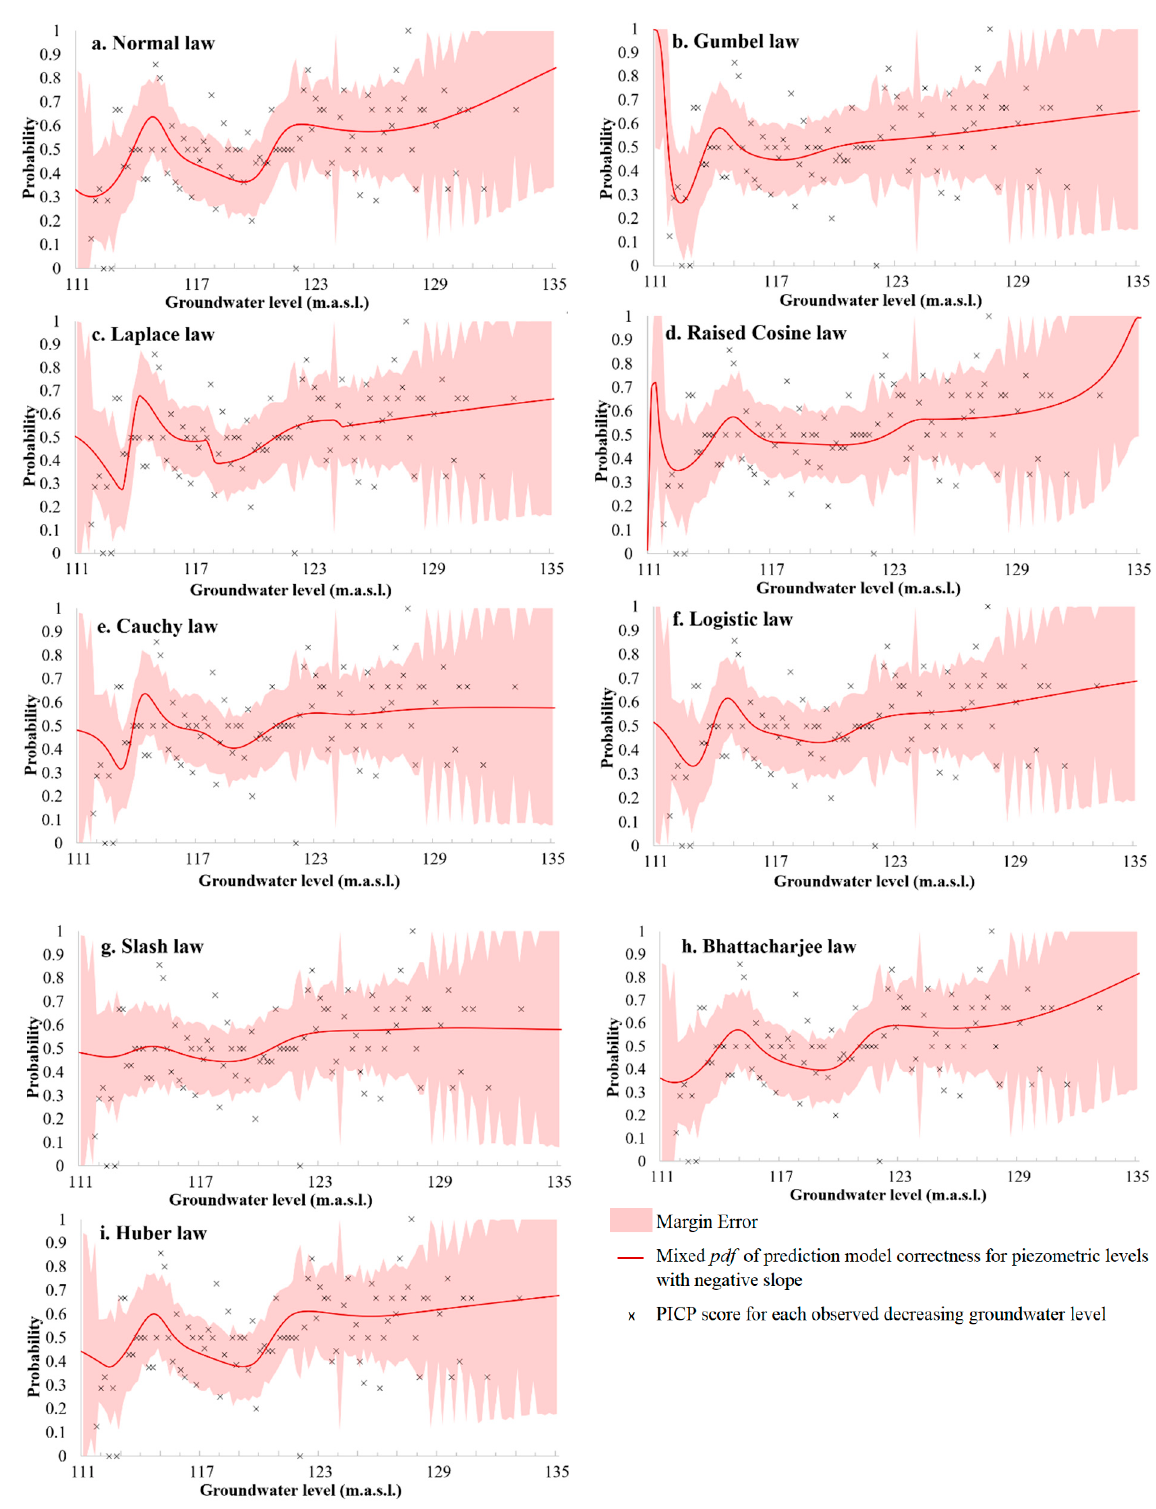
Figure 11. Models of correctness and Error margin ( M E ), calculated from composite pdf of decreasing levels and using a confidence index of 95% for ( a ) Normal law, ( b ) Gumbel law, ( c ) Laplace law, ( d ) Raised Cosine law, ( e ) Cauchy law, ( f ) Logistic law, ( g ) Slash law, ( h ) Bhattacharjee law and ( i ) Huber law.